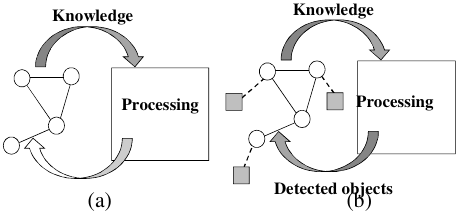
Figure . ISCM (a) Basic knowledge framework (b) Knowledge